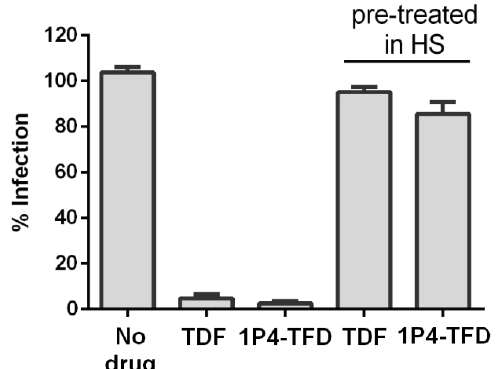
Figure 5. Comparative evaluation of the susceptibility of TDF and 1P4-TFD adduct to human serum-induced inactivation. The efficacy of the compounds against HIV-1 IIIB infection was assessed in MT-4 cells at 10× IC 50 following pretreatment with human serum for 30 min.